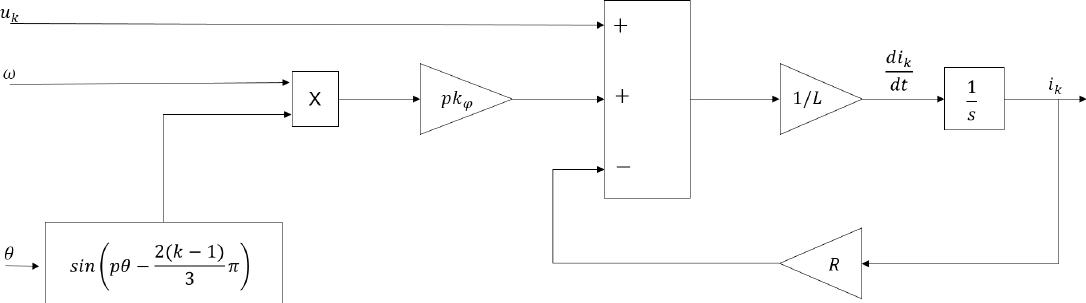
Figure 6. Block diagram of the equation for the electromagnetic equilibrium of the k -th stator